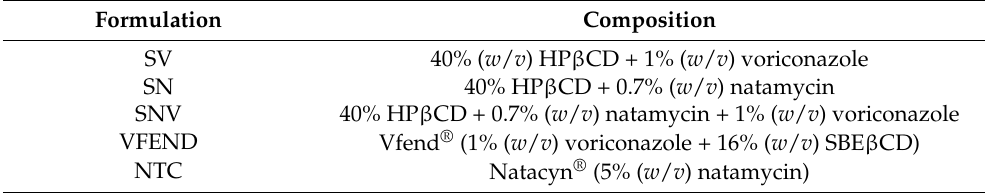
Table 2. Composition of tested formulations in Kirby–Bauer Disc Diffusion Method. Formulation